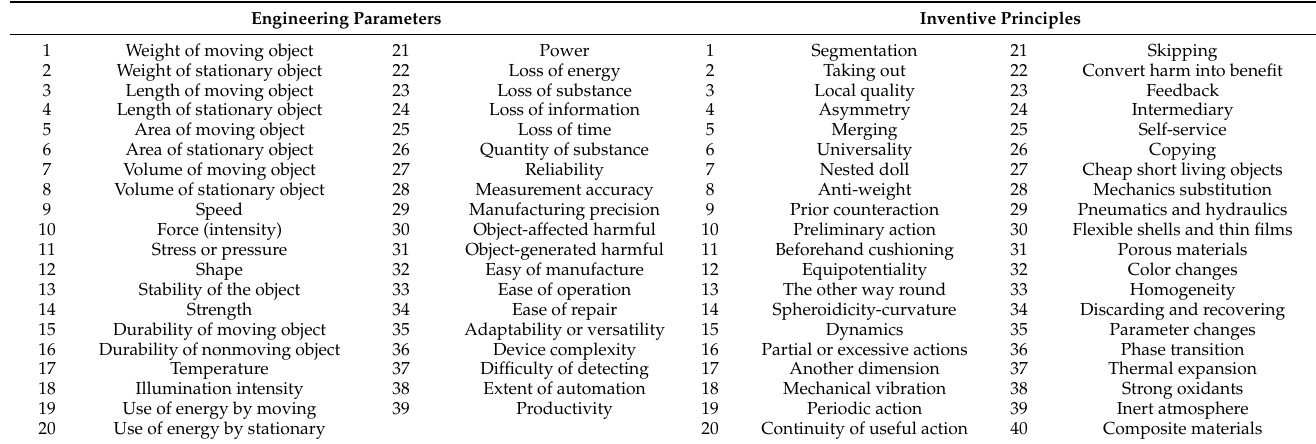
Table 1. Engineering parameters and inventive principles of TRIZ